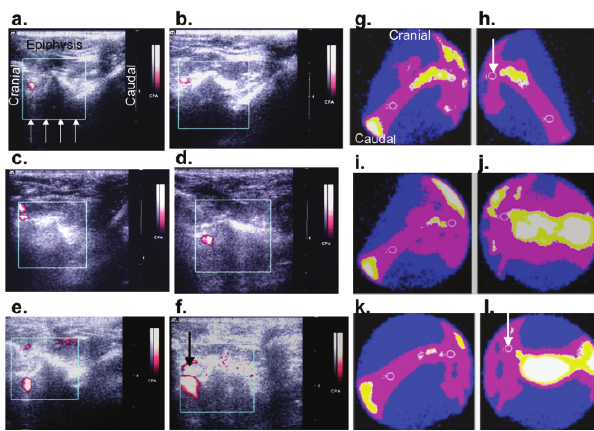
Figure 1 - Corresponding coronal power Doppler sonograms (A-F) and anterior-posterior pinhole scintigraphic (G-L) images of the proximal femura of the same adult rabbit of Fig. 2 and 3 which underwent a left intertrochanteric femoral osteotomy with internal fixation. Please note an increase number of color pixels within the operated proximal femoral epiphysis seen both with Doppler (F) and scintigraphy (L) in the late post- operative images (6 weeks after the surgical procedure). These images show that scintigraphy clearly illustrates the hypervascular process as a consequence of healing in the proximal metadiaphysis of the operated femur starting in the early post-operative stage, at a certain point in a more conclusive way than power Doppler sonography. Nevertheless with regard to the diagnostic accuracy for discrimination of the operative status of the proximal femoral epiphysis our study results demonstrated a greater diagnostic performance for Doppler sonography. Number of color pixels calculated in the region of interest within the operated/unoperated hips in the pre-operative, early and late stages for power Doppler sonography were 1867/1688, 2812/3476, 12557/7560, and for scintigraphy were 61.6/62.2, 44.8/39.4, 63/51.1. The regions-of-interest used for analysis of power Doppler sonography were the squared color boxes (arrows, A) and for analysis of scintigraphy were the circles at the level of the proximal femoral epiphyses (arrow,